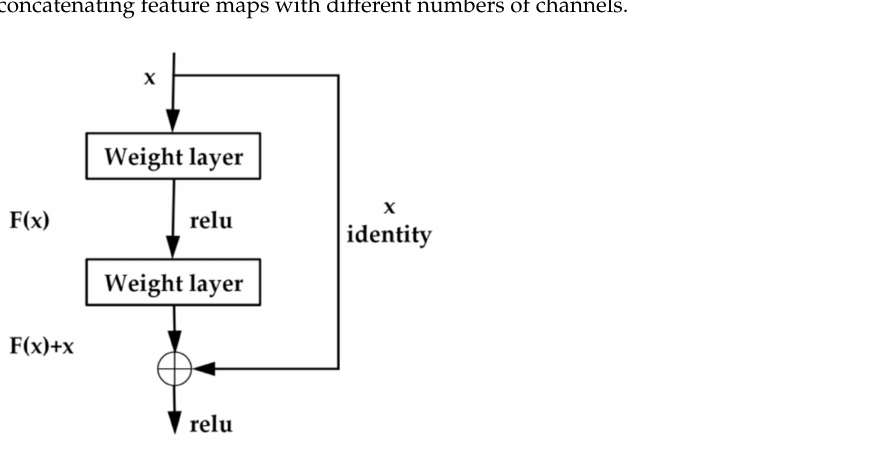
Figure 4. Network structure of residual learning. “F(x)” refers to the residual and “x” is the feature mapping of the output of the previous layer